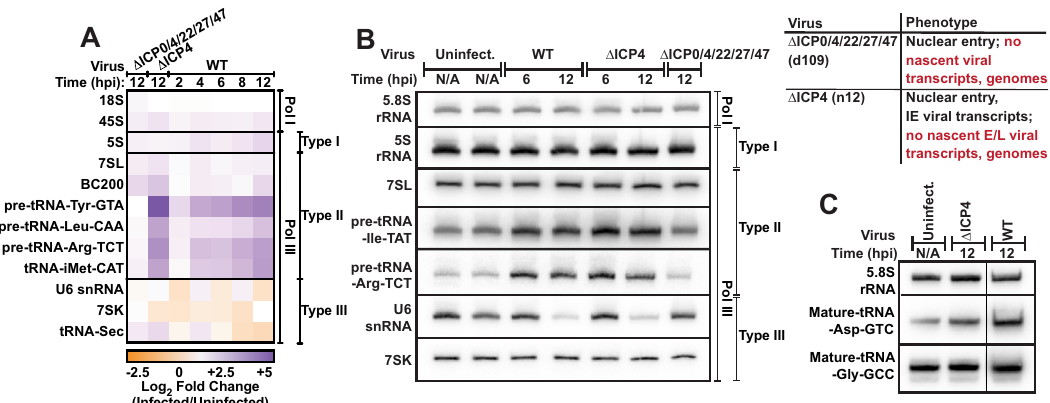
Fig. 1 Impact of HSV-1 productive infection on Pol I and III transcripts. Human fi broblast cells were mock-infected or infected with Δ ICP0/4/22/27/47 (d109), Δ ICP4 (n12), or wild-type HSV-1. RNA was isolated at indicated times, and A qPCR or B , C Northern blots were used to assess transcript abundance. A Data is the average of biological triplicate experiments, and values are average log 2 fold change of infected over uninfected samples. cDNA copy number was calculated using genomic DNA standard curves and as a function of total RNA used for reverse transcription. B , C Images are representative Northern blots from at least two biological replicates, data is quanti fi ed in Supplementary